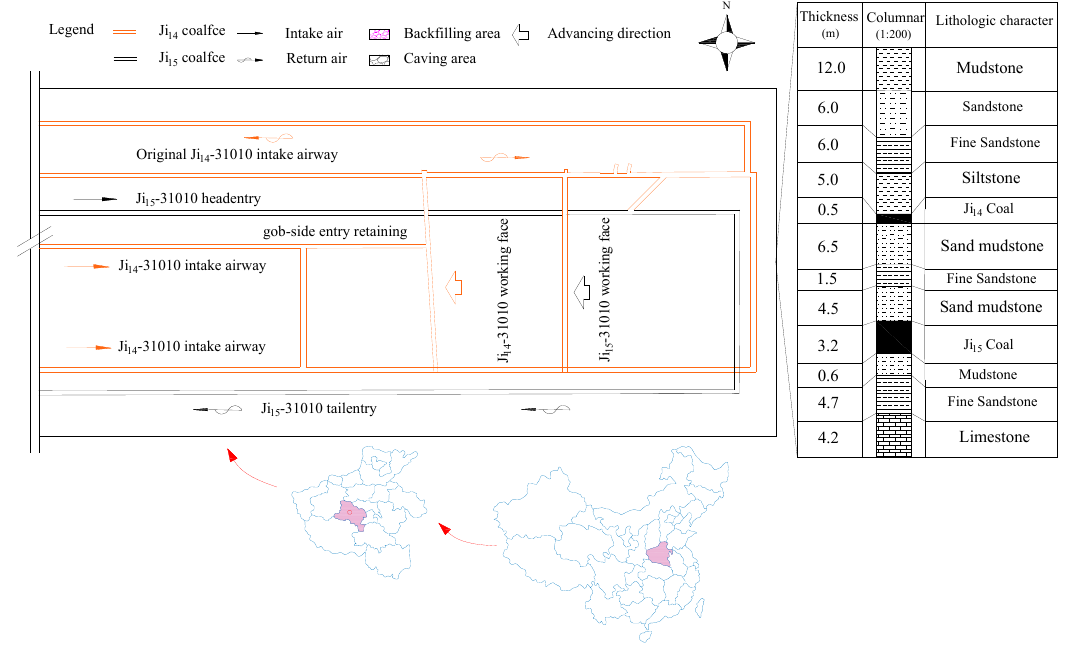
Figure 1. Roadway layout of the mining district in the Ji 15 and Ji 14 seams.